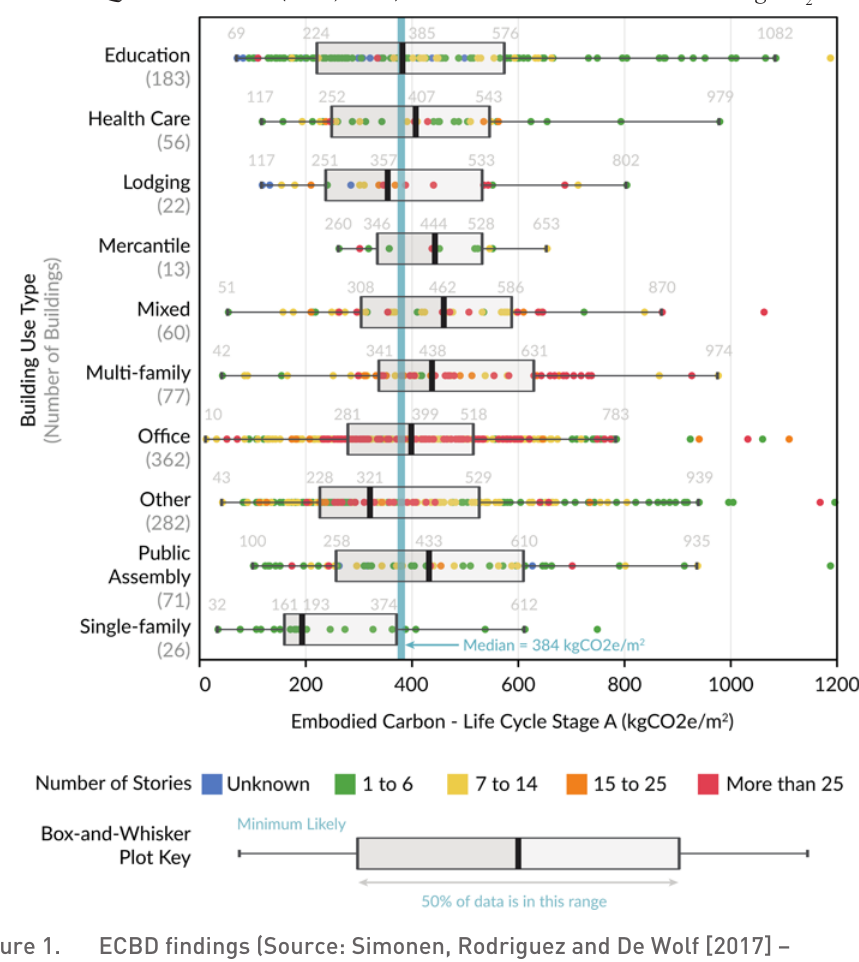
Figure 1. ECBD findings (Source: Simonen, Rodriguez and De Wolf [2017] – reproduced with permission of lead